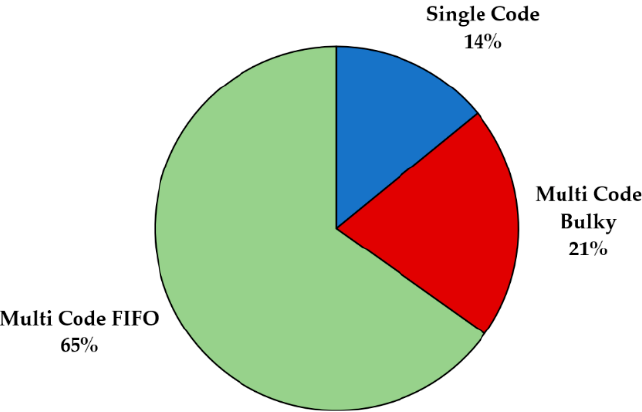
Figure 6. Percentage of time spent processing each type of pallet.